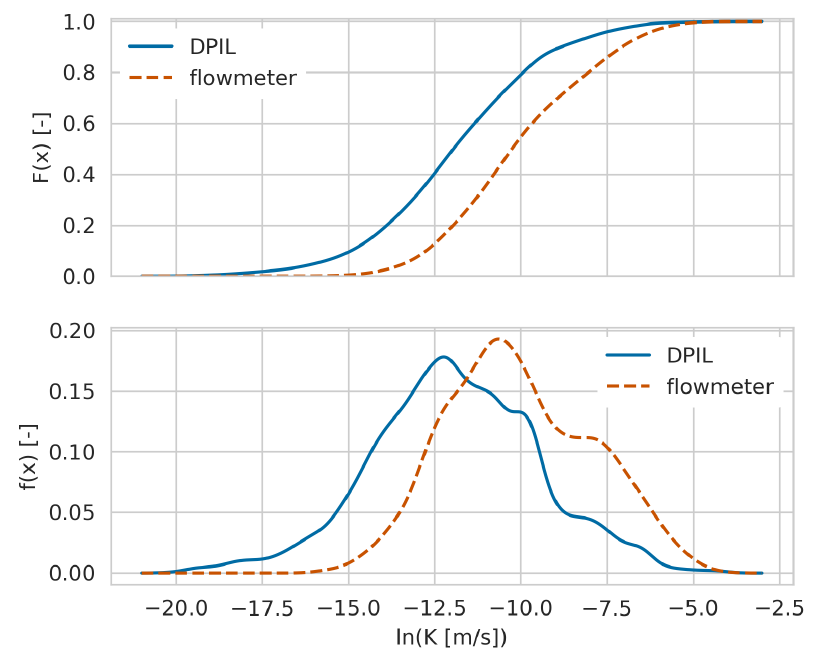
Figure 2. CDF (upper panel) and the PDF (bottom panel) of ln ( K ) as measured by DPIL and flowmeter analysis at the MADE